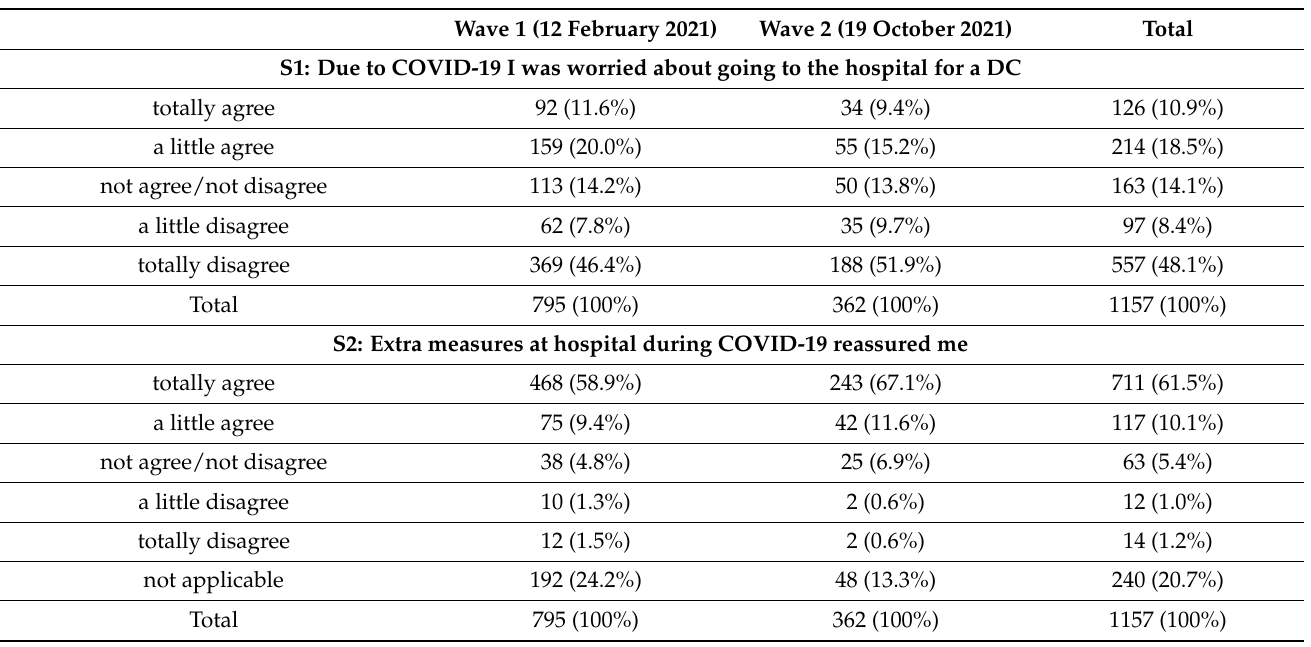
Table 4. Survey statements results of group DC performed only at the time of the survey (according to survey waves), in absolute numbers and percentages.